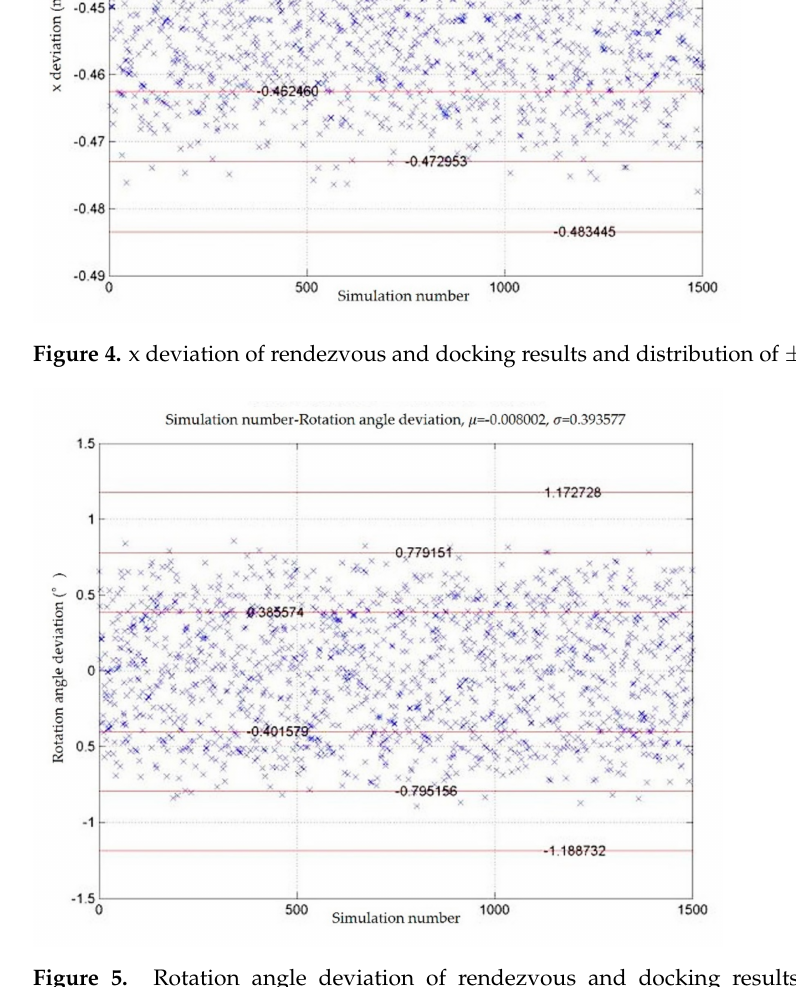
Figure 5. Rotation angle deviation of rendezvous and docking results and distribution of ± σ , ± 2 σ , ± 3 σ